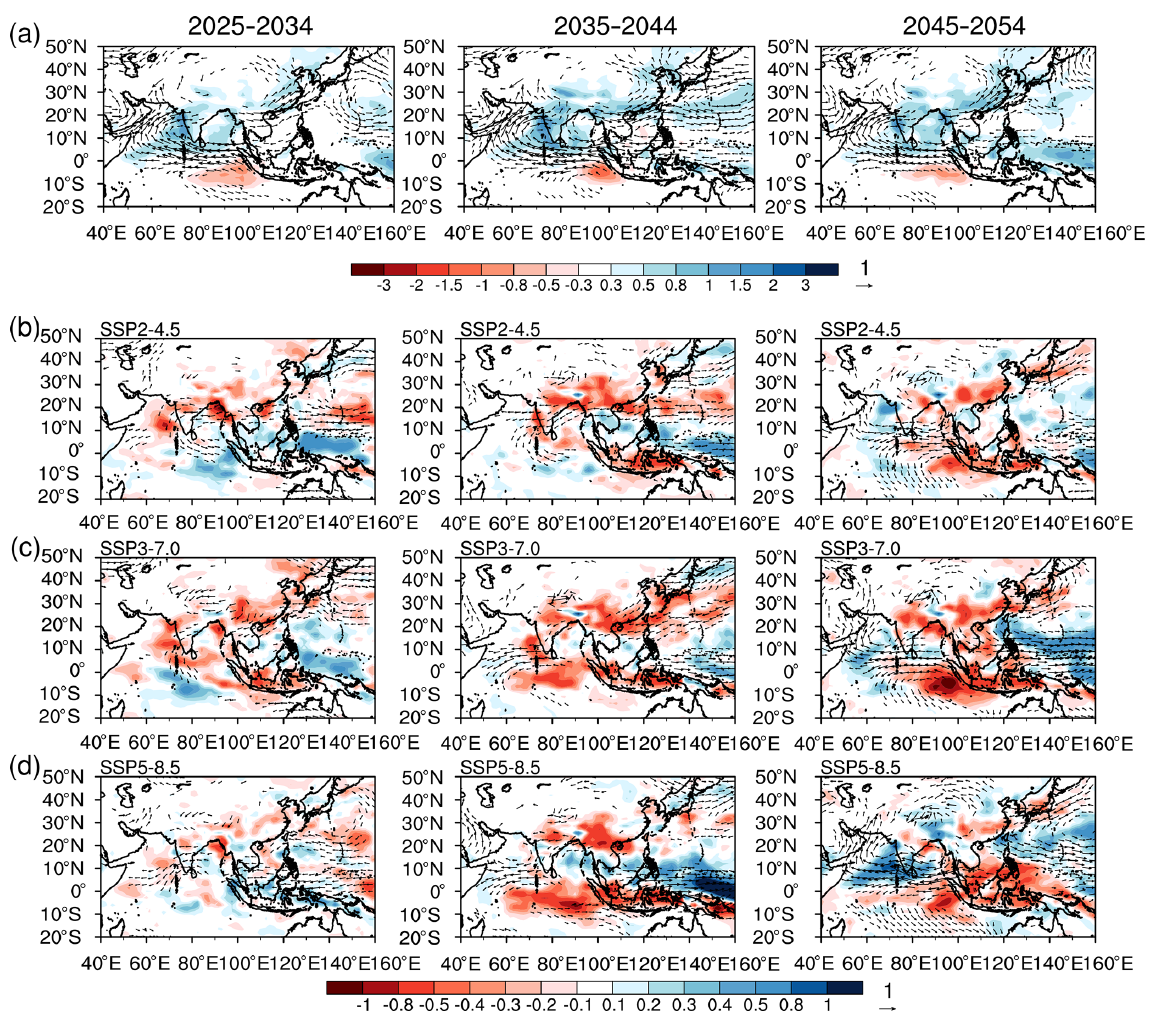
Figure 12. (a) JJA-mean precipitation (mmd − 1 ) and 850hPa wind anomalies (ms − 1 ) for 2025–2034, 2035–2044, and 2045–2054 vs. 1980– 2014 from SSP1-1.9. Anomalies from (b) SSP2-4.5, (c) SSP3-7.0, and (d) SSP5-8.5 relative to the anomalies from SSP1-1.9. To enable a fair comparison of the precipitation patterns, only models with data availability for all scenarios are used (see Table